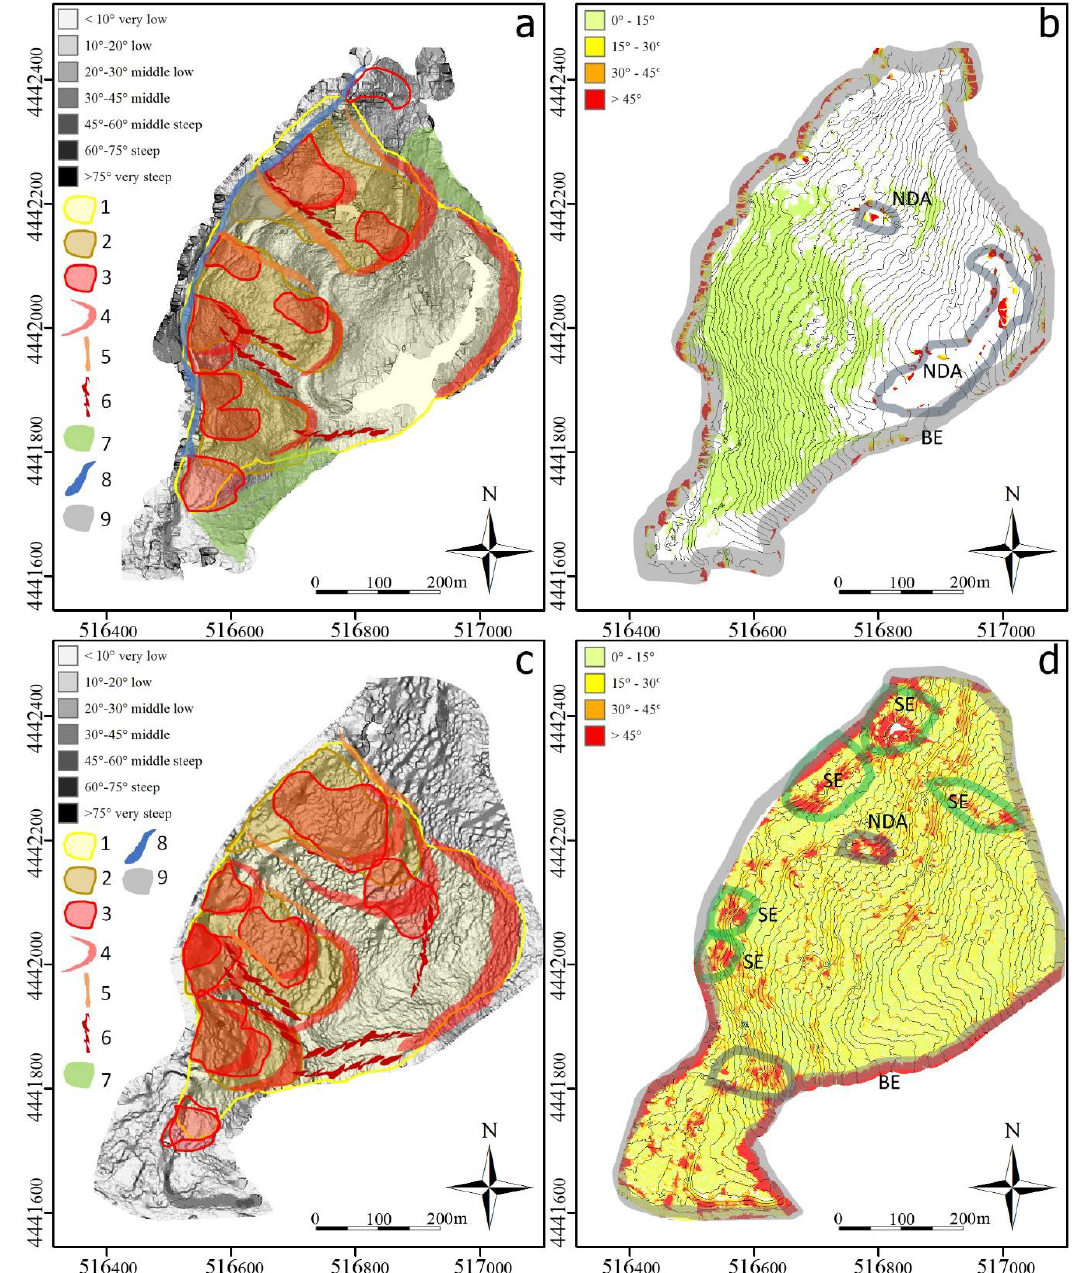
Figure 9. ( a ) Slope map using TLS data; ( b ) relative standard deviation; ( c ) slope map using HRSI; ( d ) relative standard deviation. On the maps of uncertainty ( b , d ), coding of the more probable origin of the errors is added: BE = boundary Effect, NDA = non-instrumentally detected area, SE = shadow effect.